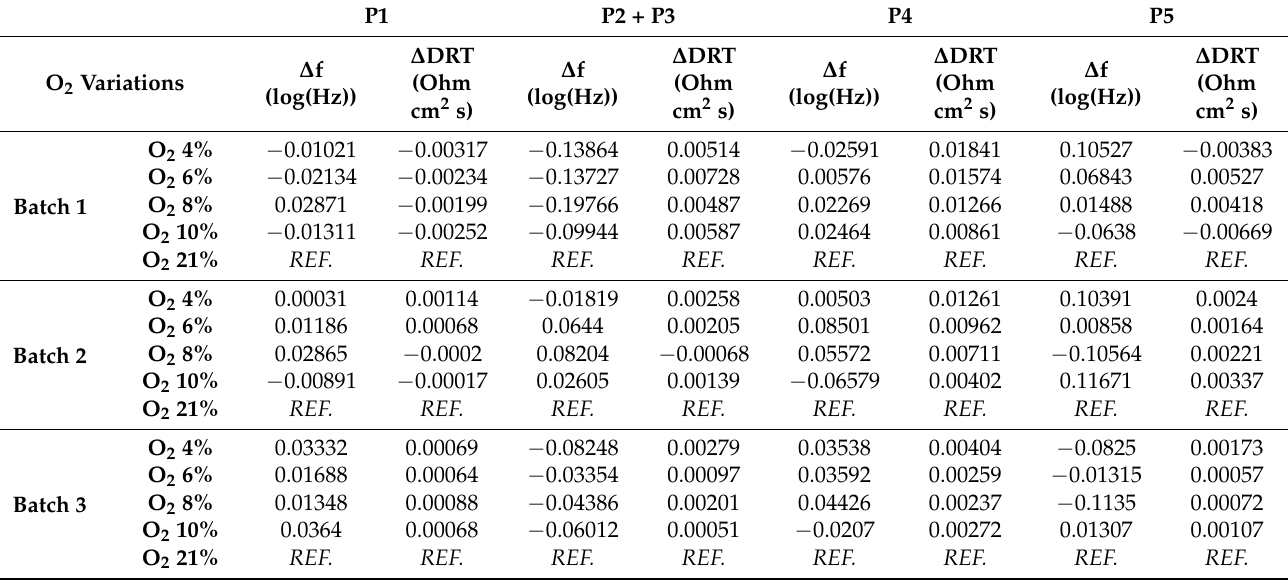
Table 5. Frequency and DRT amplitude change due to oxygen variation at 700 ◦ C and H 2 90%. REF. stands for the reference value. P1 P2 + P3 P4